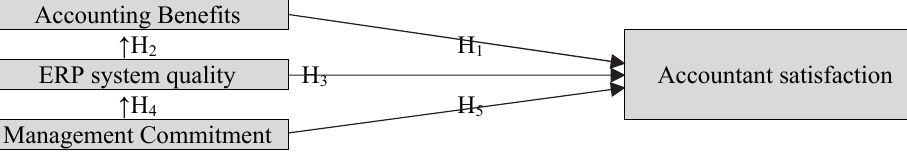
Fig. 1. Theoretical framework of the